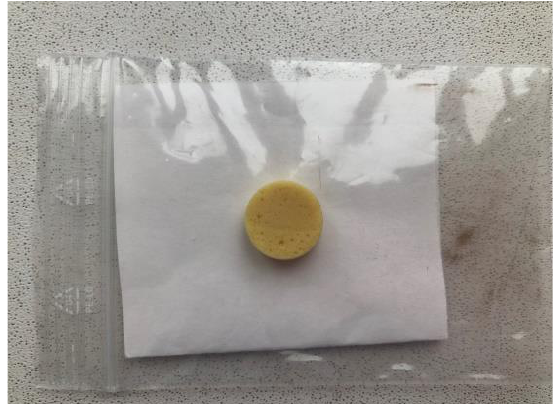
Figure 3. Representative photograph of one of the studied specimens — appearance.